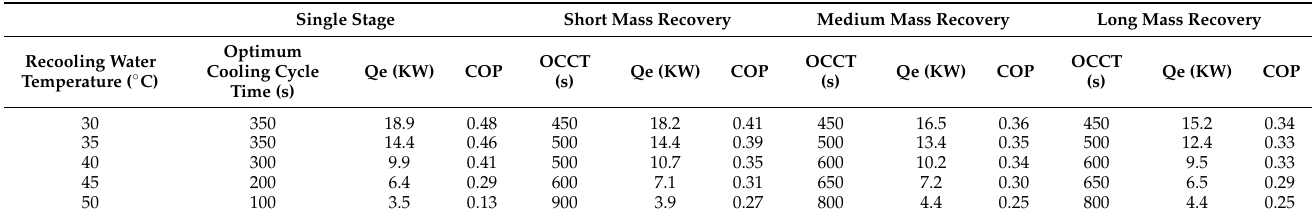
Table 5. Optimum cycle time for each cycle mode.